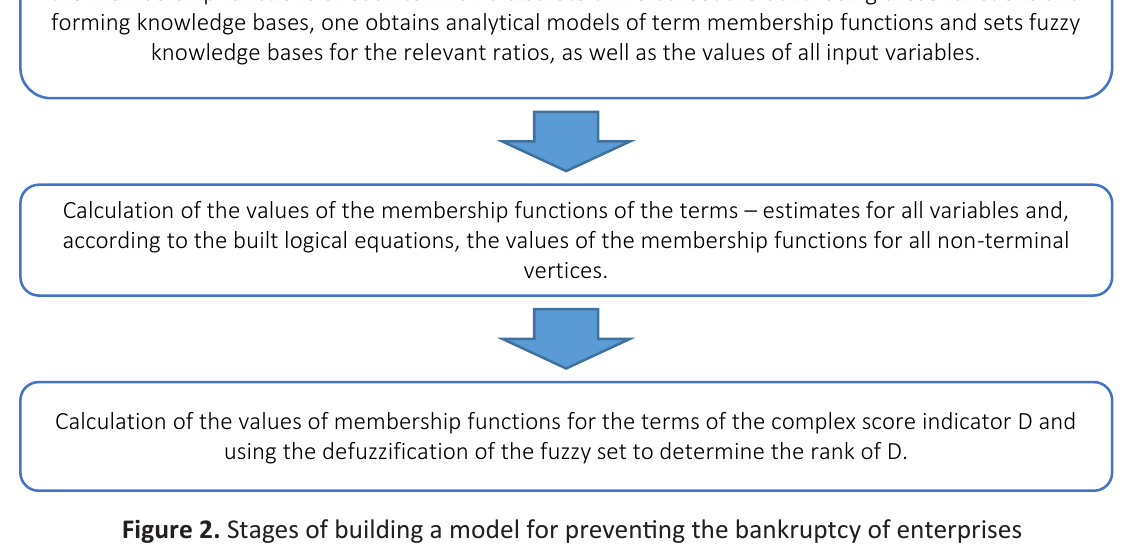
Figure 2. Stages of building a model for preventing the bankruptcy of enterprises